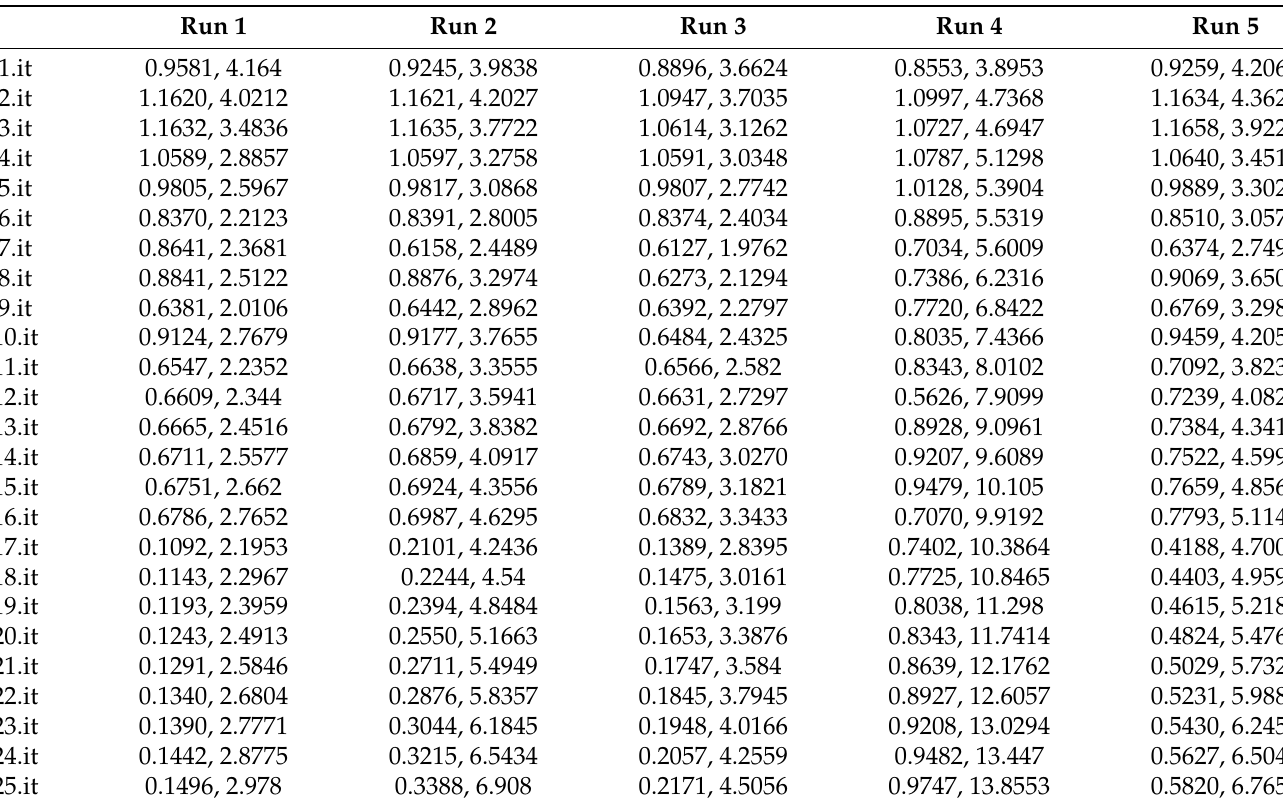
Table 11. The distances (Euclidean, Manhattan) between the testing and the proposed algorithm for (cid:96) = 40.